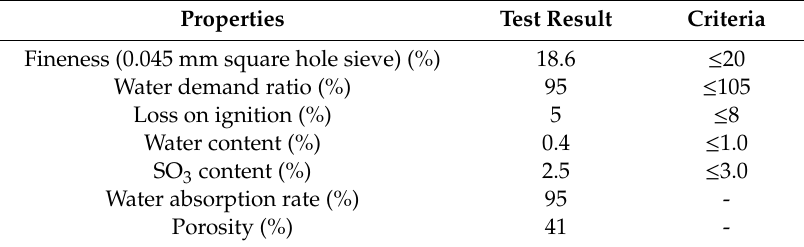
Table 5. Basic performance of fly ash.